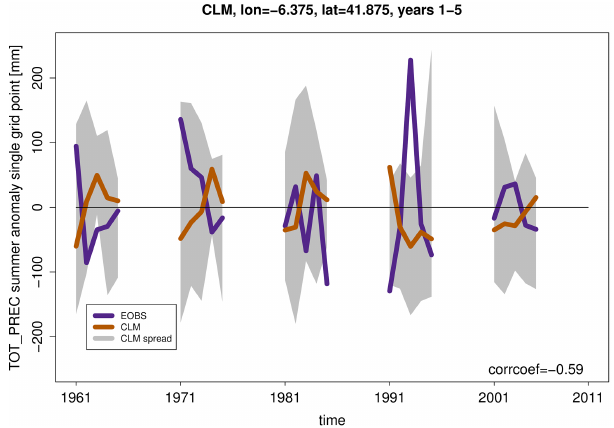
Figure 5. CCLM summer precipitation for lead years 1–5 in north- ern Spain at the border to